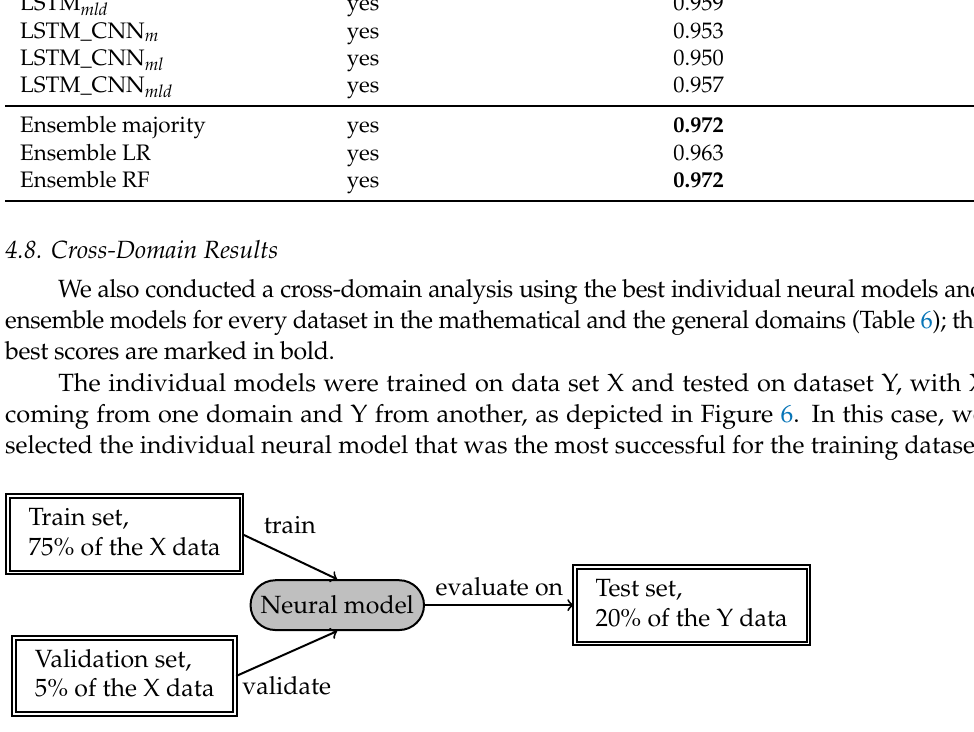
Figure 6. Pipeline of cross-domain evaluation of individual NN models for X (training) → Y (test)